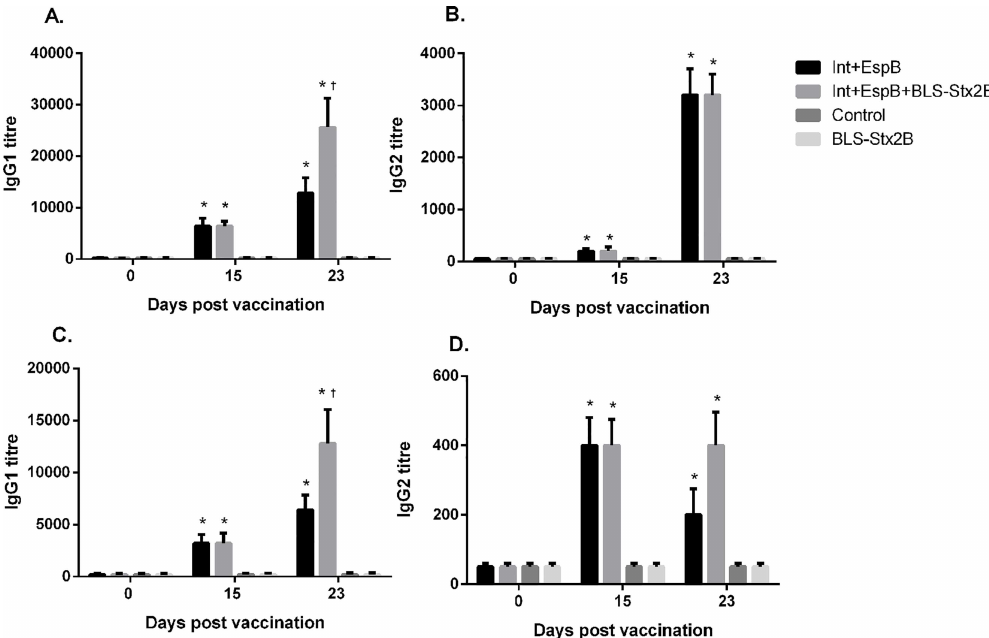
Fig 1. Immunoglobulin G1 (A,C) and G2 (B,D) responses to IntiminC 280 (A, B) and EspB (C,D) in calves vaccinated with IntiminC 280 + EspB + BLS-Stx2B (3Ag); IntiminC 280 + EspB (2Ag); BLS-Stx2B and PBS (control) measuredby ELISA at different times post vaccination.Data are shown as titers (as reciprocal of dilutions) ± standarderror of the mean. * Indicates statistical significance(p < 0.05) comparedto the control and † indicatesstatistical significance comparedto the 2Ag group.